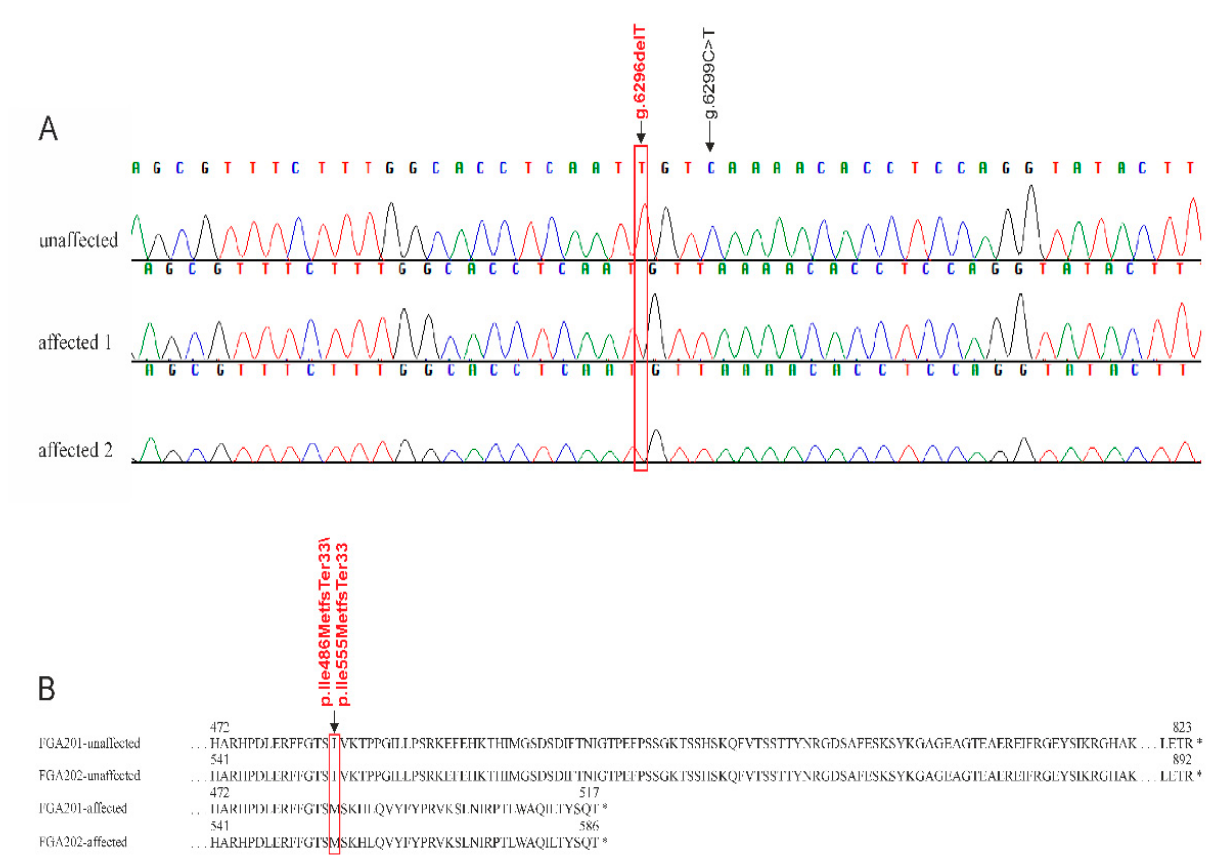
Figure 3. Frameshift mutation in afibrinogenemia-affected Dachshunds. Nucleotide key for the respective individual is given above the chromatogram. Chromatograms from sequencing analysis show the frameshift variant FGA :g.6296delT (rs1152388481) in both affected dogs (affected 1–2, identical to case 1–2; ( A )). Comparisons of the predicted protein sequence of FGA transcripts ( FGA201 and FGA202 ) in affected and unaffected dogs display a significant shortening of the amino acid sequence due to the frameshift mutation ( B ).